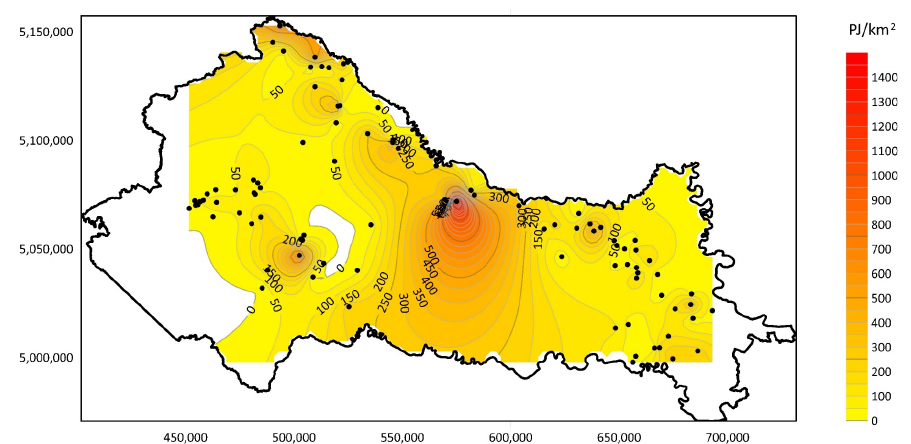
Figure 17. Mean heat-in-place areal distribution—syn-rift phase.